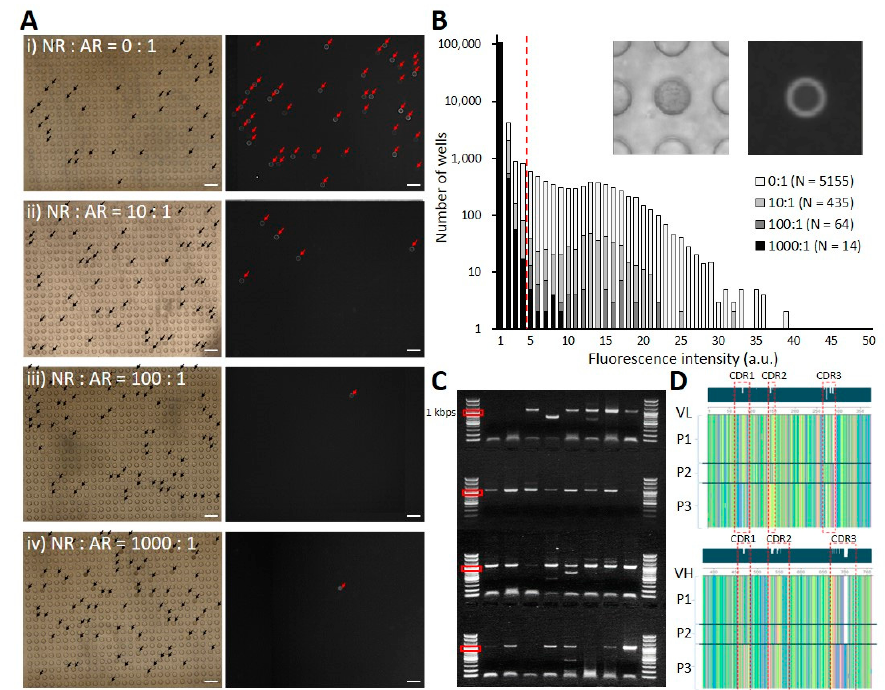
Figure 3. Validation experiments. ( A ) Microscopy images of microwells before (left, brightfield) and after (right, fluorescence) chip disassembly. The ratios of non-reactive (NR):antigen reactive (AR) phage clones were adjusted to 0:1 ( i ), 10:1 ( ii ), 100:1 ( iii ), and 1000:1 ( iv ), respectively. Arrows indicate microwells showing distinct cell occupancy (black) or fluorescence signal (red). All scale bars are 200 µ m. ( B ) Distribution of fluorescence intensities extracted from the four experiments. The red dashed line indicates the fluorescence intensity threshold for AR signals. Inset shows microscopy images of a representative microwell. ( C ) Representative gel electrophoresis result of single-chain variable fragment (scFv) products amplified from retrieved clones. ( D ) Multiple sequence alignment result of identified clones. Three di ff erent AR P1, P2, and P3 phage clones were mixed in a ratio of 1:1:1 at the time of cell